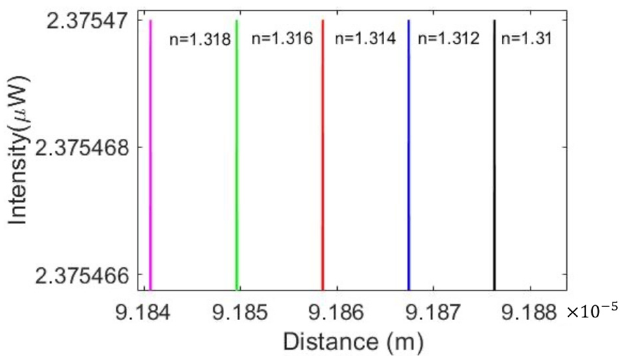
layer conditions.